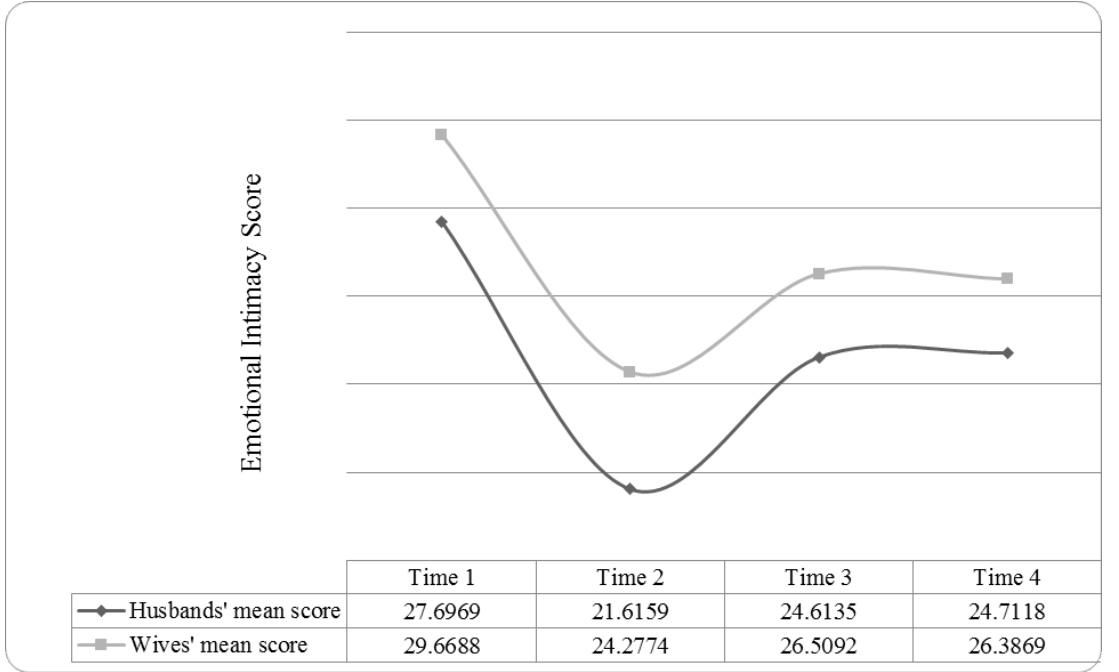
Figure 1. Growth trajectories of husbands’ and wives’ observed emotional intimacy at all four time points. Means are for parallel measures created for analyses.